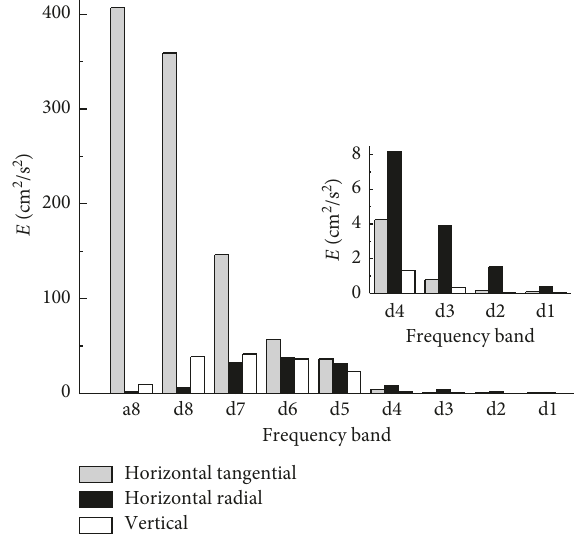
Figure 6: Energies of reconstructed signals in each band. Table 7: SWE in different distances from the blast-face to the monitoring points. Distance from the measured point to the blast-face